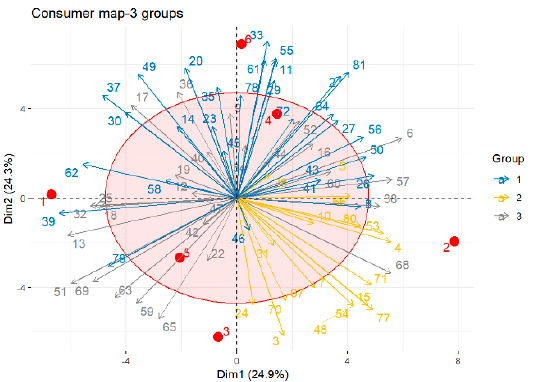
Figure 5. The 2-D map of the consumer liking pattern according to their preference patterns using k-means clustering and PCA.